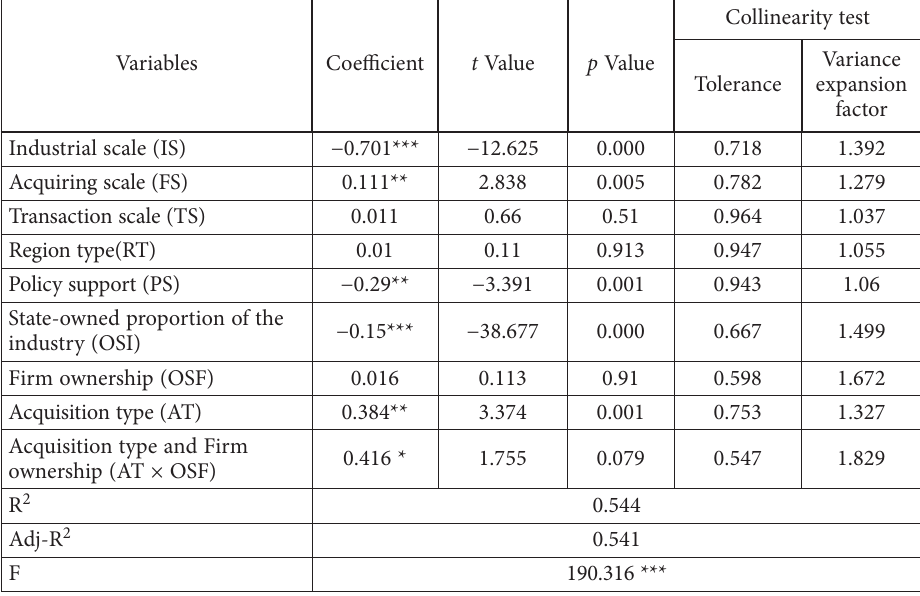
Table 6. The moderating effect of firm ownership characteristics